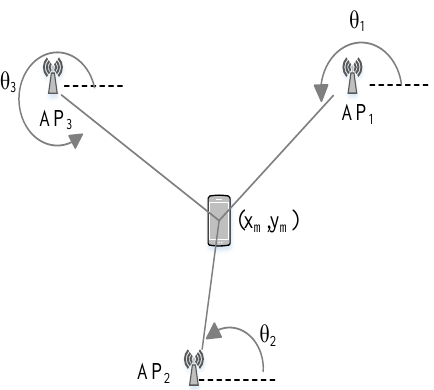
Figure 4. Localization based on angle of arrival (AOA) measurement.